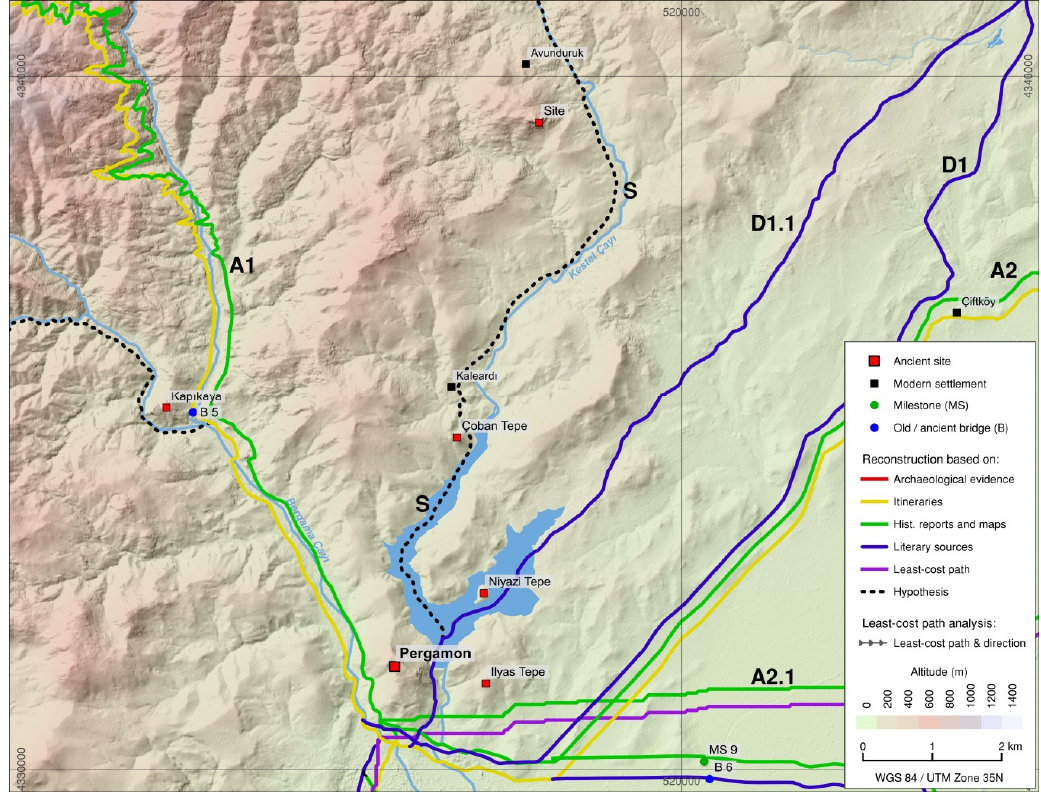
Figure 27. Reconstructed route from Pergamon through the Kestel Creek Valley into the Kozak Mountains.